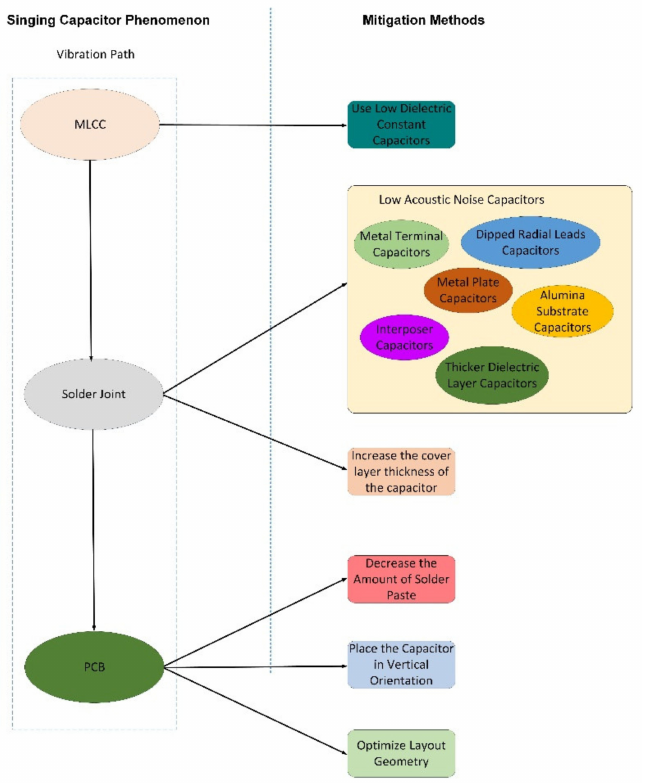
Figure 3. Solutions for singing capacitor